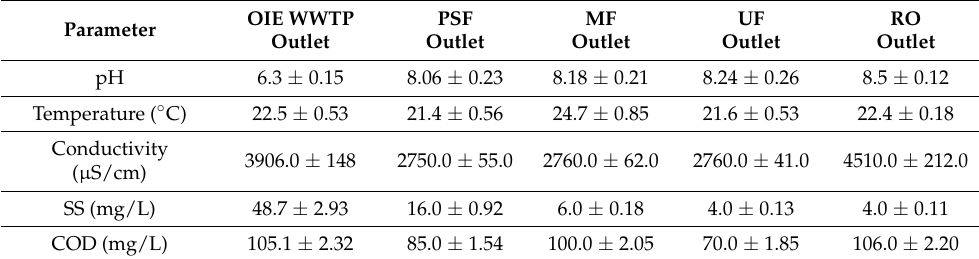
Table 1. Output values of OIE WWTP and pilot-plant